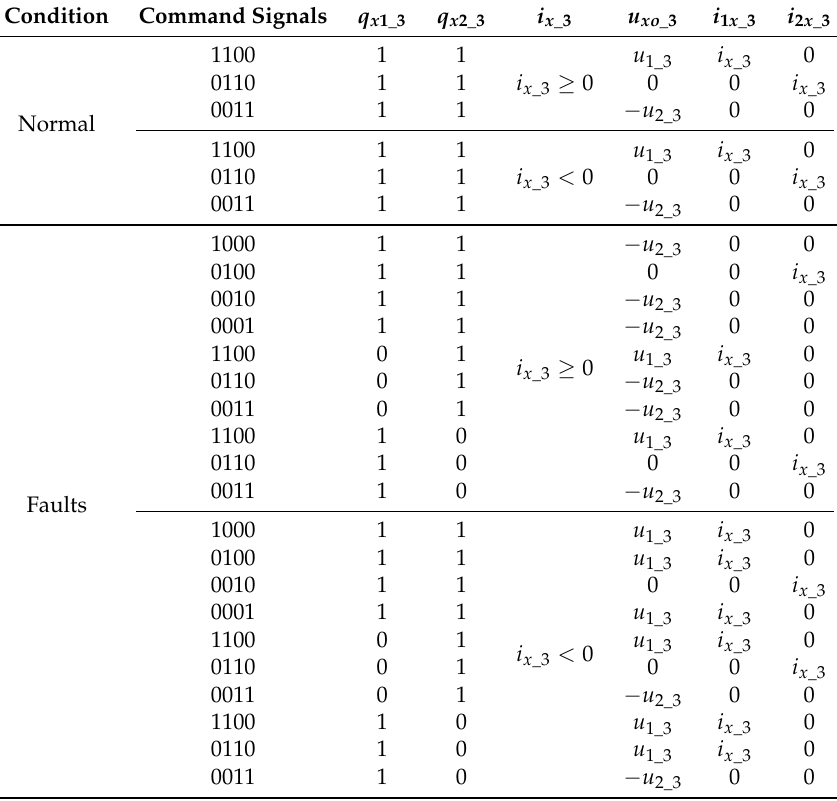
Table 2. Relationship between inputs and outputs of a single three-level